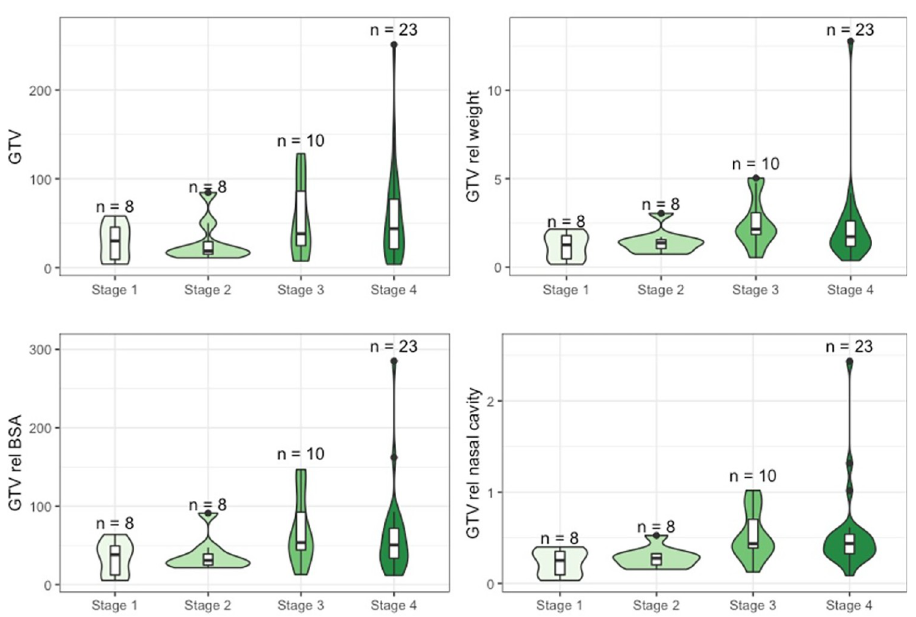
Fig 2. Distribution of GTVs according to modified Adams tumor stage. Violin plots depicting the distribution of absolute and relative tumor volumes of all 49 dogs depending on the different tumor stages. There was a statistically significant difference between GTVs relative to nasal cavity and the different tumor stages (p = 0.005). Here, stage 1 tumors were significantly smaller than stage 3 tumors (p = 0.026), stage 1 tumors smaller than stage 4 tumors (p = 0.026), stage 2 tumors smaller than stage 3 tumors (p = 0.04) and stage 2 tumors smaller than stage 4 tumors (p = 0.027).